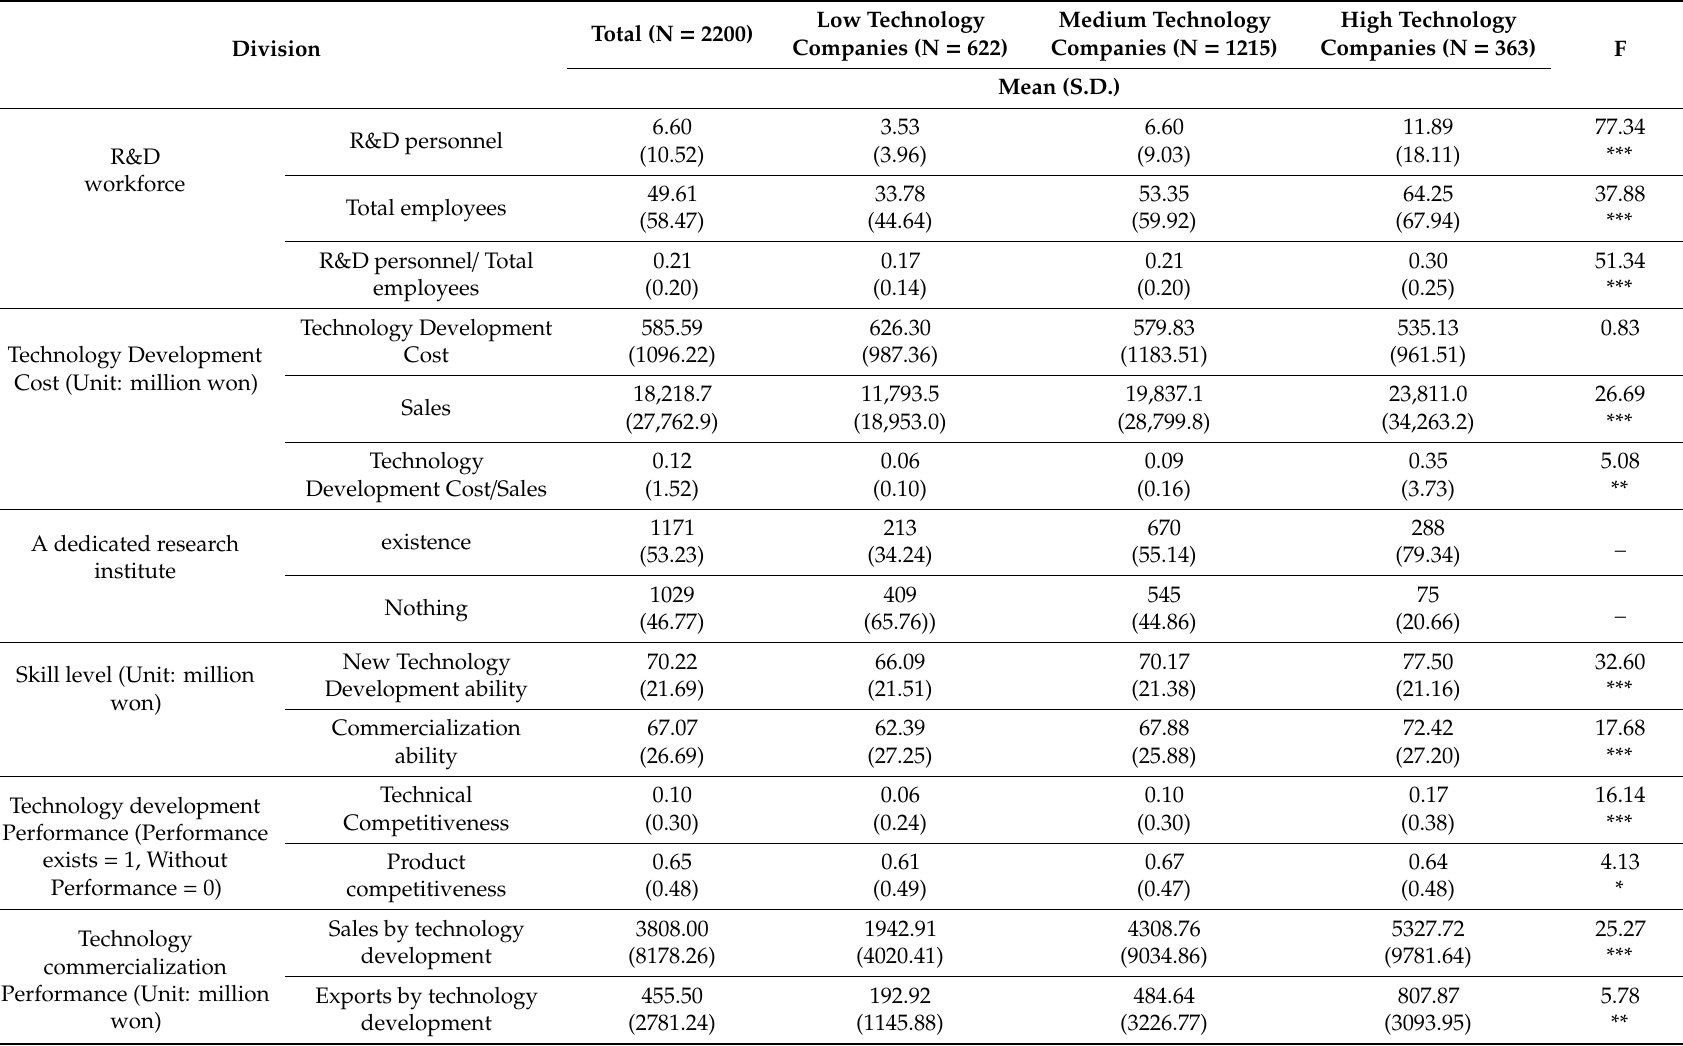
Table 2. Comparison of technology development capabilities, technology development performance, and technology commercialization performance according to technology